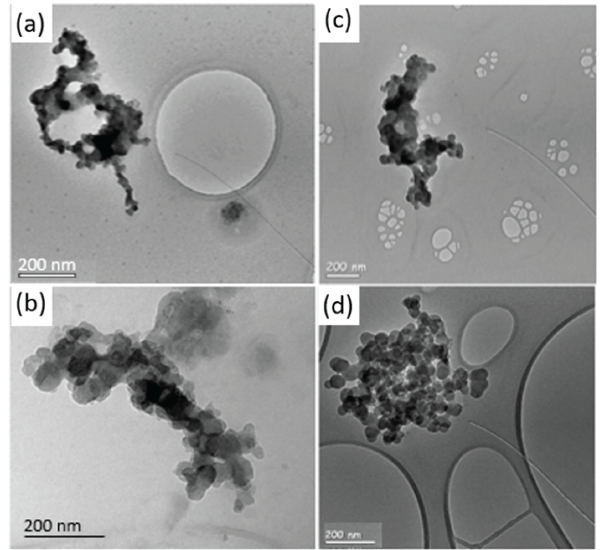
Figure 7. Transmission electron microscope/microscopy (TEM) images of black carbon particle aggregates collected on 30 Au- gust 2017 (a) , 31 August 2017 (b) , 2 October 2018 (c) , and 3 Octo- ber 2018 (d) on copper grid polycarbonate filters.